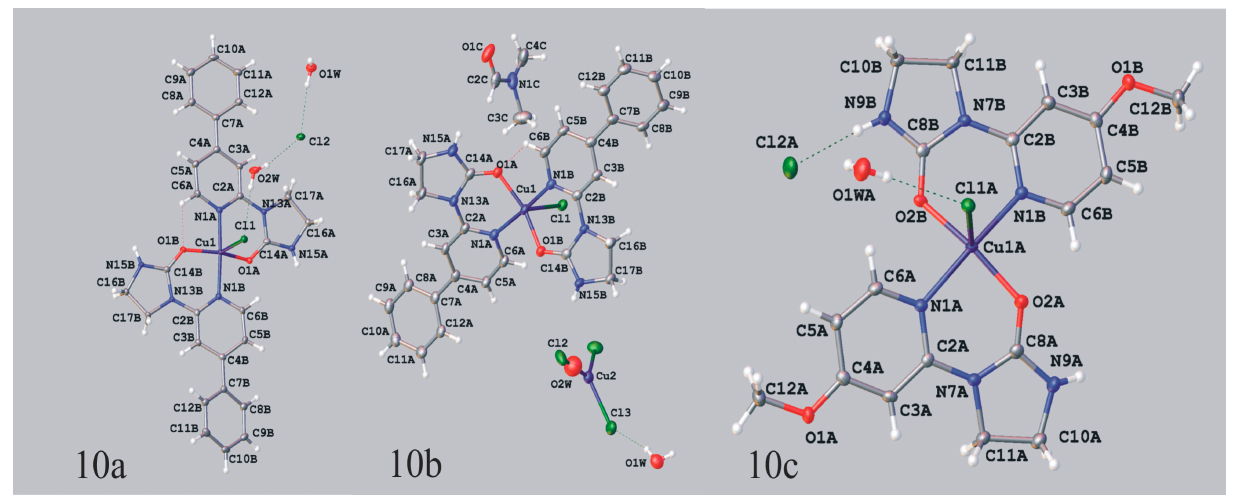
Figure 7. ORTEP representation of molecular structure of 10a (Cl − counterion), 10b (CuCl 3 − counterion) and 10c (Cl − counterion). Hydrogen bonds are shown with dashed